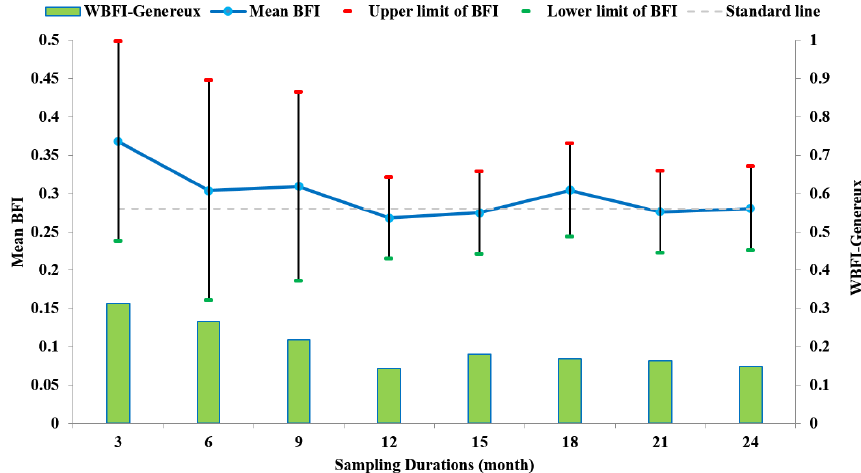
Figure 5. Values and variations of mean BFI and W BFI-Genereux with different sampling